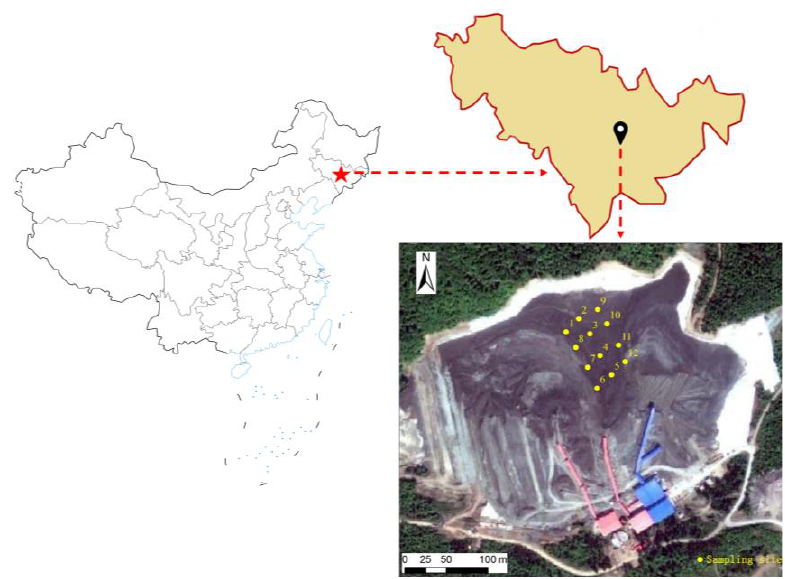
Figure 1. Location map of tailings pond and layout of sampling points.